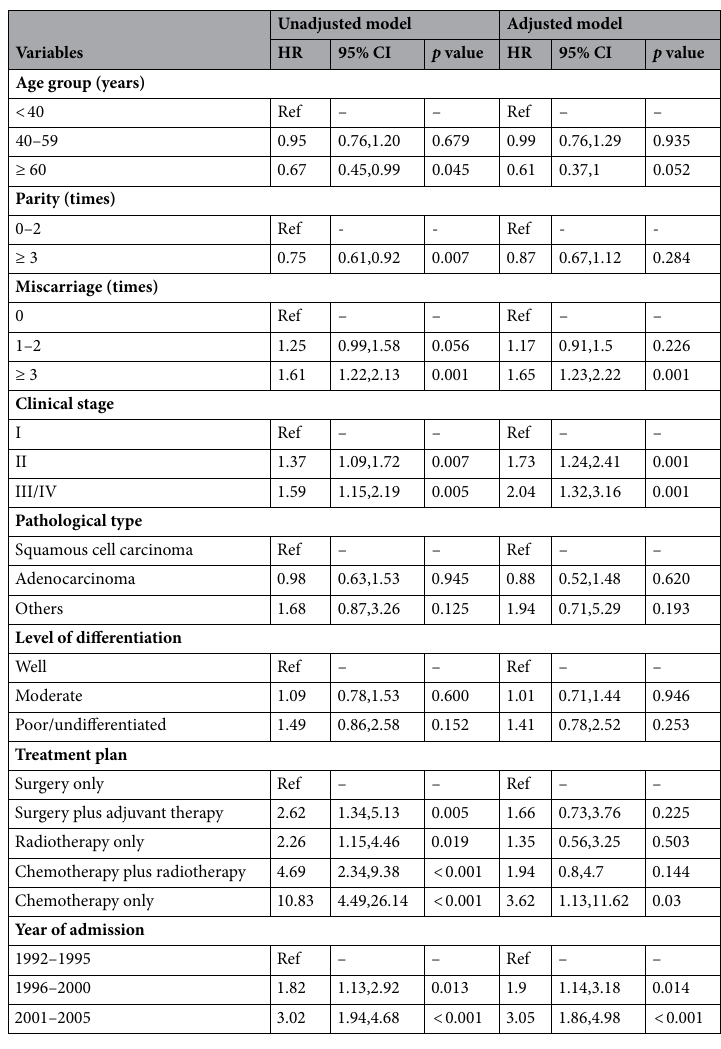
Table 3. Analyzing factors associated with cervical cancer recurrence using Cox regression models. HR hazard ratio, CI confidence